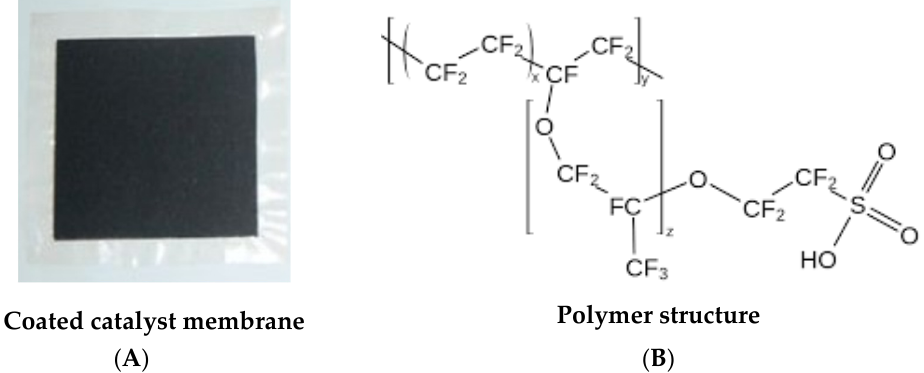
Figure 3. ( A ) Image of Ir-Pt-CCM of Nafion™ 117; ( B ) chemical structure of Nafion™ 117.